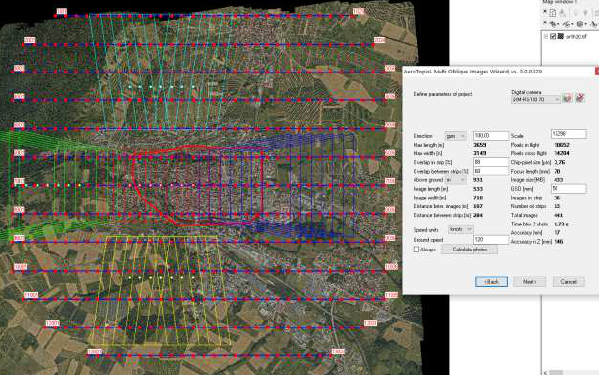
Figure 4: Mission plan with AeroTopoL The Camera was installed in a Cessna 206 designed for aerial survey with a big hole. The entire flight time over the area was about 50', mainly because of the turns into the new mission line. In average each 1.7 sec a image-set was captured with 550 MPIX. In total 441 *550 MPix = 242 GPPix have been used to model the inner city. A controller with 4 Tbyte SSD Hard drives stored the images fast and save in the raw